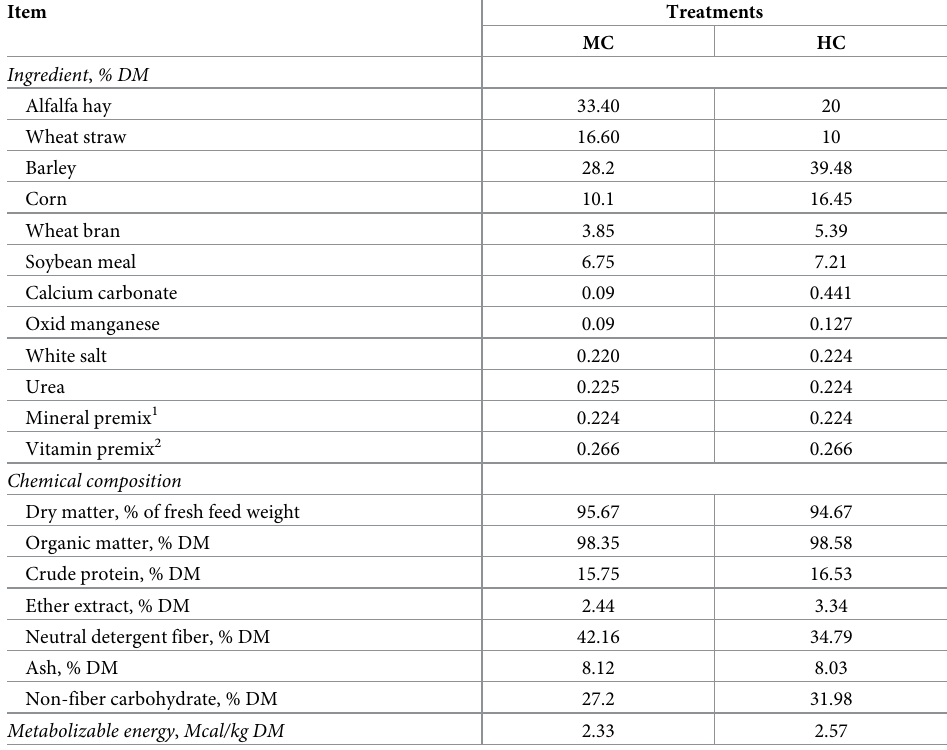
Table 1. Ingredients and chemical composition of experimental